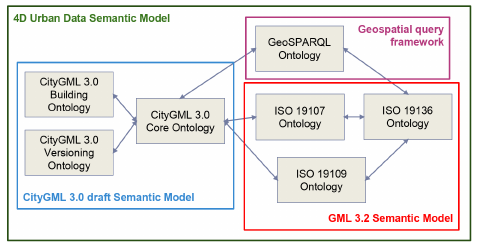
Figure 1. 4D Urban Data Semantic model as a network of